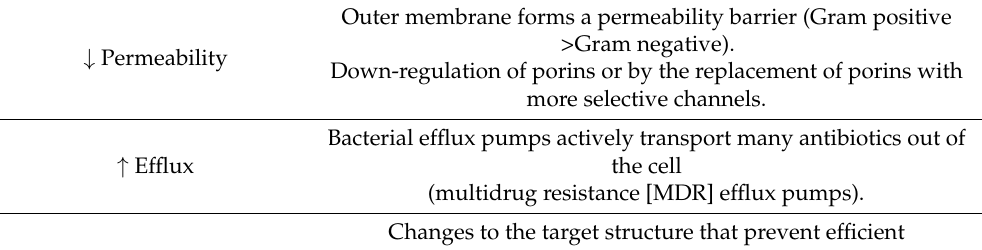
Table 1. Molecular mechanisms of antibiotic